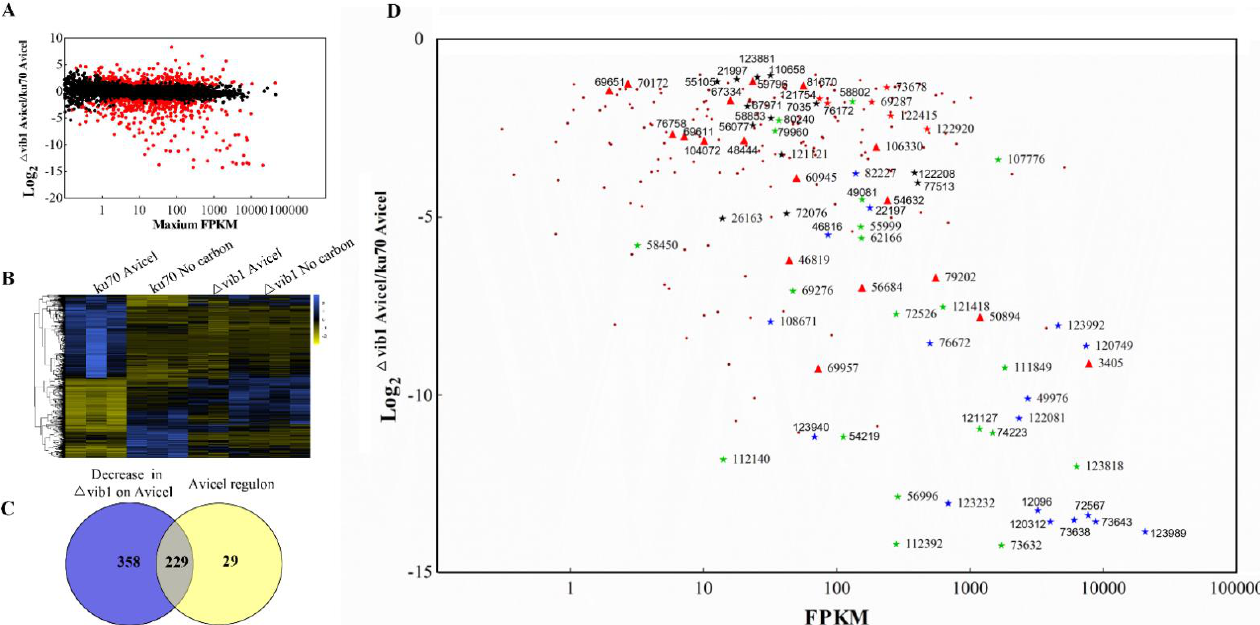
Figure 2. Transcriptional response of the ∆ vib1 mutant to cellulose induction. ( A ) Genome-wide analysis of the influence of VibIB1 on the transcriptomes of T. reesei on Avicel. Log 2 ratio of ∆ vib1 /TU6 on Avicel vs. maximum FPKM in either condition. Genes exhibiting differential expression (|Log 2 fold change| ≥ 1 and adjusted p -value < 0.05) are indicated with a red dot. ( B ) Hierarchical clustering of expression levels in ∆ vib1 and TU6 for 707 genes differentially expressed in TU6 on Avicel cellulose and no carbon. Data from three biological replicates were included, and the expression level of gene was indicated with log 10 FPKM. ( C ) Venn diagram of genes downregulated in the ∆ vib1 mutant on Avicel cellulose compared to the Avicel regulon. ( D ) Fold change and expression level of the gene set within the Avicel regulon whose expression was downregulated in ∆ vib1 on Avicel cellulose. Log 2 ratio of ∆ vib 1/TU6 read-count vs. FPKM in TU6 on Avicel was plotted. Genes encoding cellulase ( (cid:70) ), hemicellulase ( (cid:70) ), transcriptional factor ( (cid:70) ), sugar transporter ( (cid:78) ), and secretory pathway component ( (cid:70) ) are labeled with protein ID and indicated by the different symbols and colors. The other genes are indicated by red dot